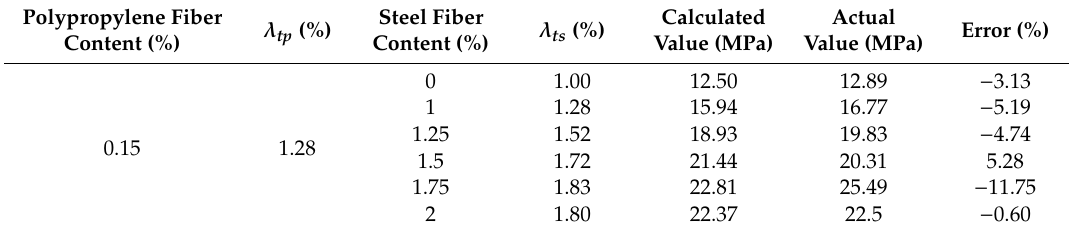
Table 17. Splitting tensile strength of hybrid polypropylene-steel fiber RPC at 28 days.